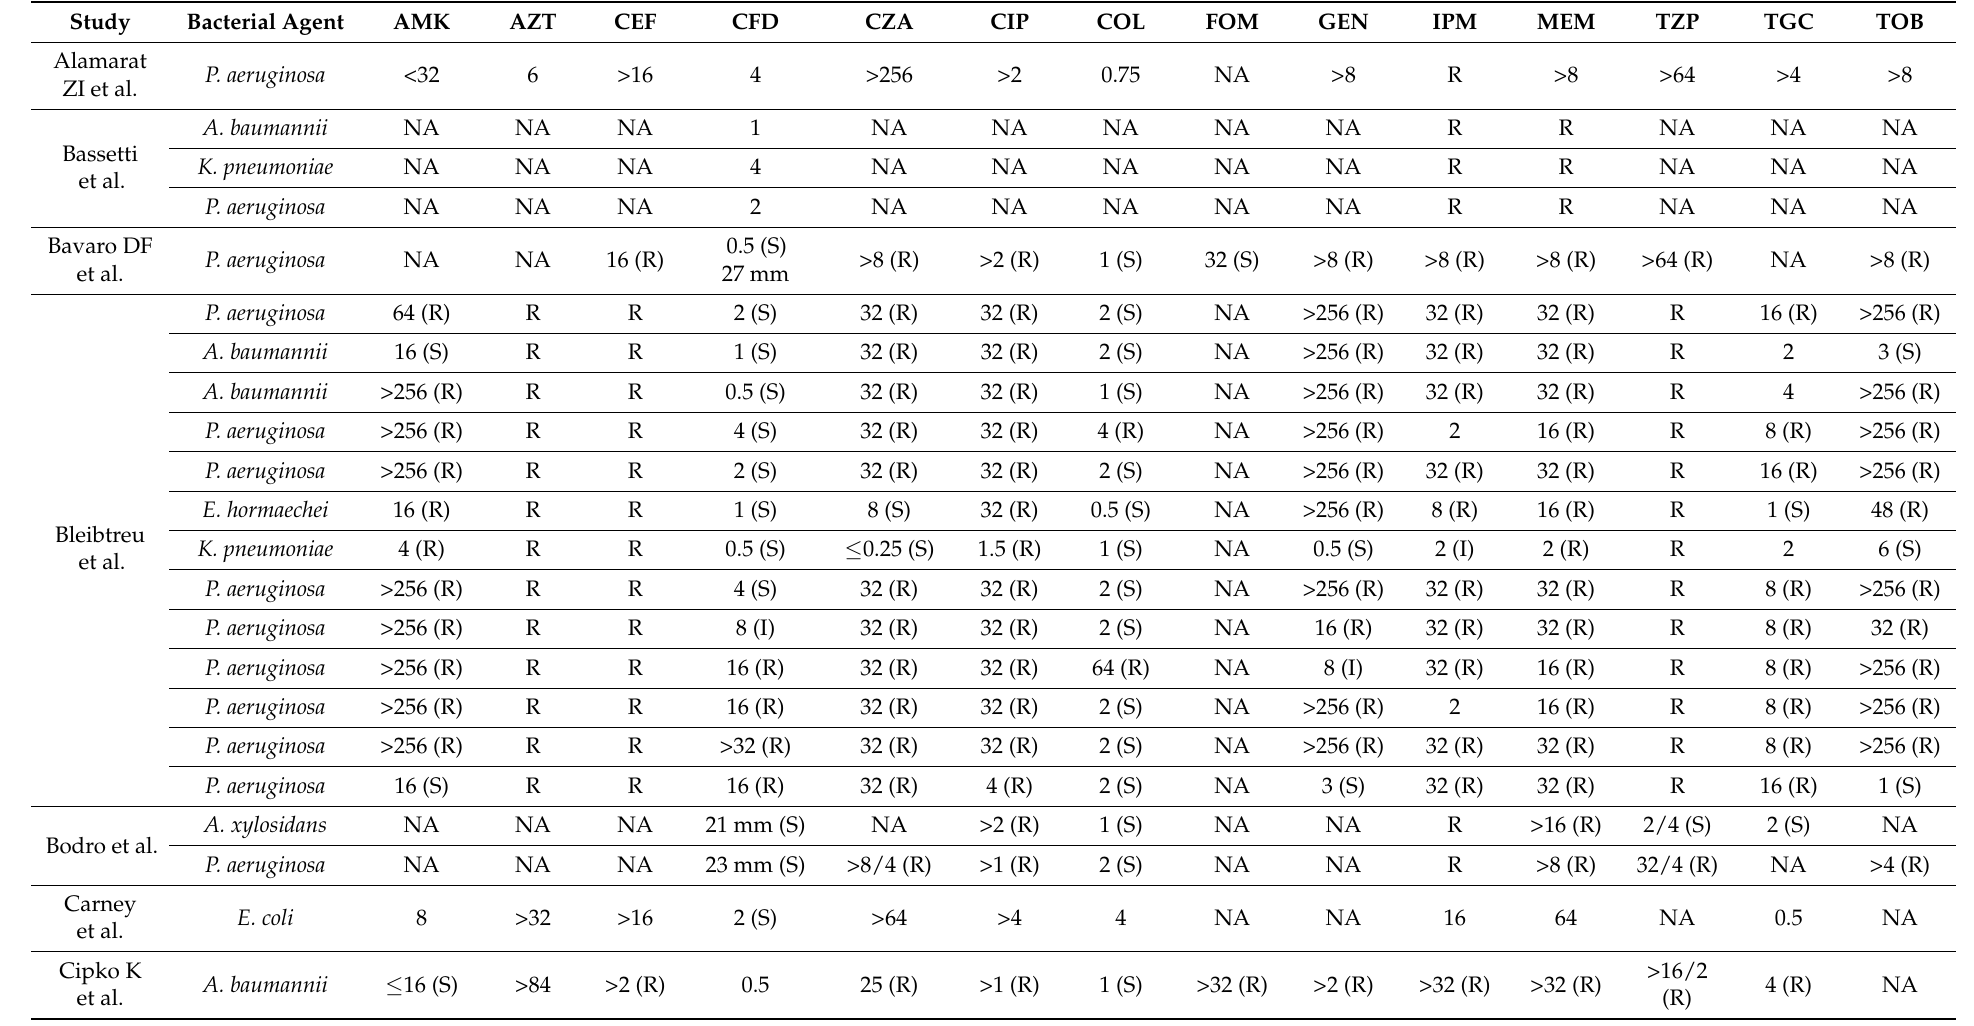
Table 4. Susceptibility Patterns (minimal inhibitory concentration (MIC) or zone of inhibition (ZOI)) of Treated Gram-Negative